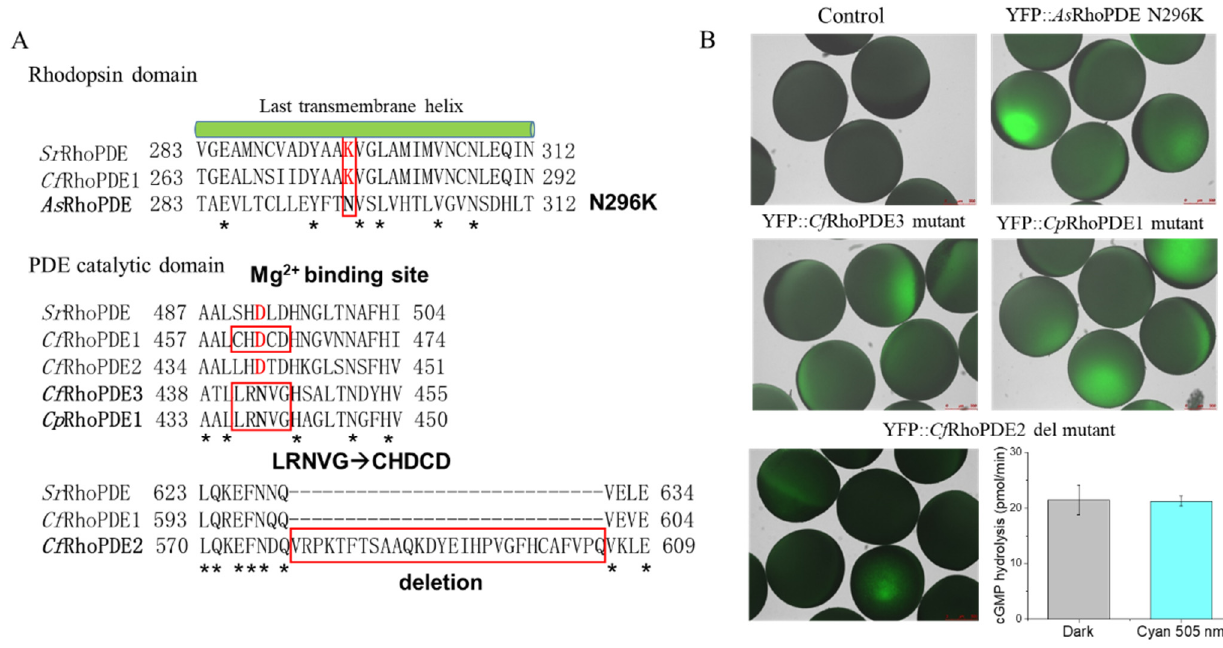
Figure 5. Comparison of key residues of non ‐ functional RhoPDEs. ( A ) Alignment of the non ‐ func ‐ tional RhoPDEs to functional RhoPDEs in crucial domains. YFP:: As RhoPDE N296K mutant